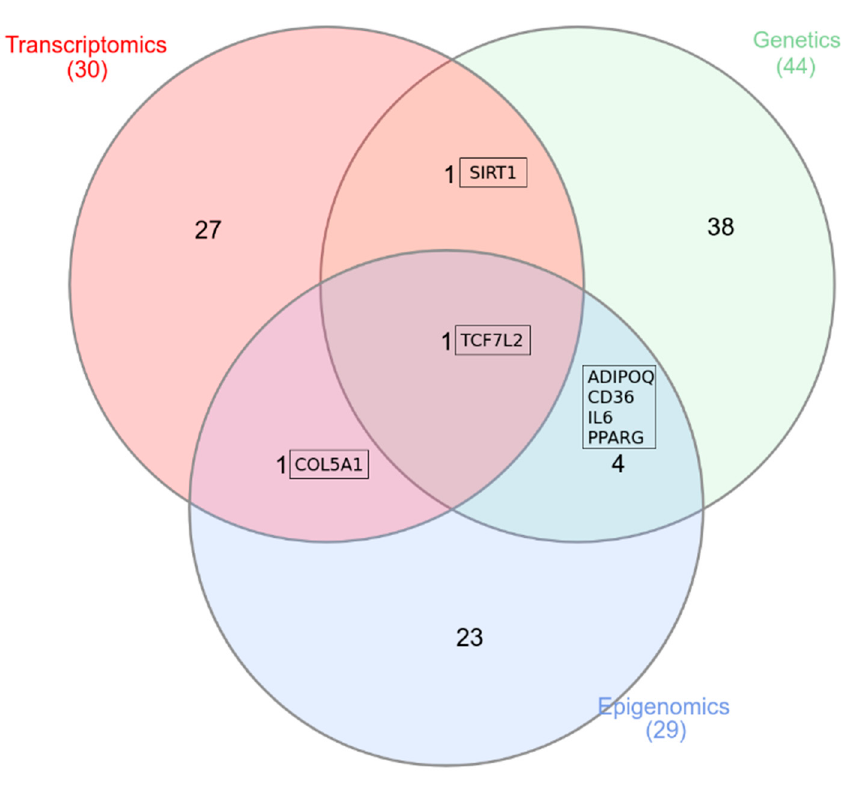
Figure 1. Venn diagram collecting the genes reported in omics approaches in adipose tissue. This figure shows the overlapping between genetics, epigenomics, and transcriptomic unveiling the role of ECM loci in obesity and metabolic comorbidities. ADIPOQ , adiponectin, C1Q, and collagen domain-containing; CD36 , cluster of differentiation 36; COL5A1 , collagen type V alpha 1 chain; IL6 , interleukin-6; PPARG , peroxisome proliferator-activated receptor gamma; SIRT1 , sirtuin-1; TCF7L2 , transcription factor 7 like